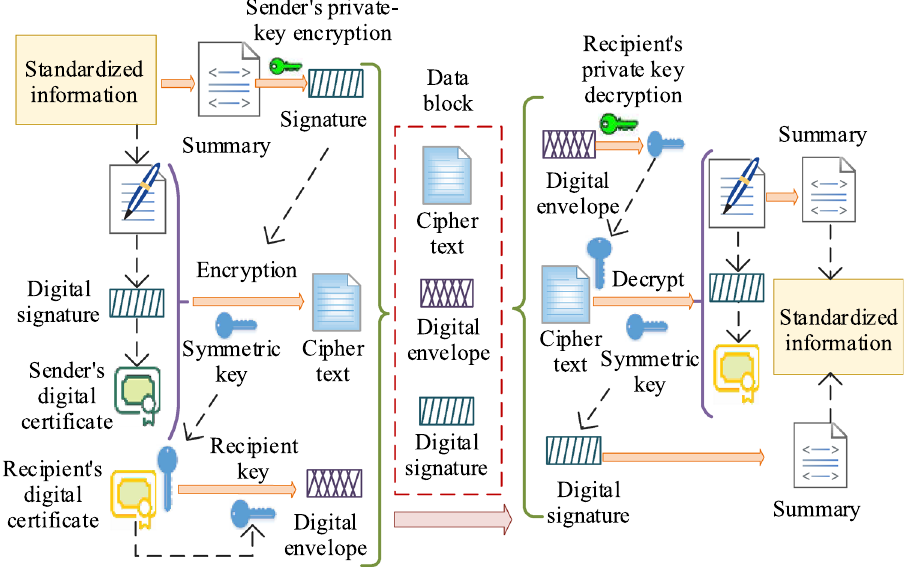
Figure 4. Asymmetric encryption process of the blockchain.